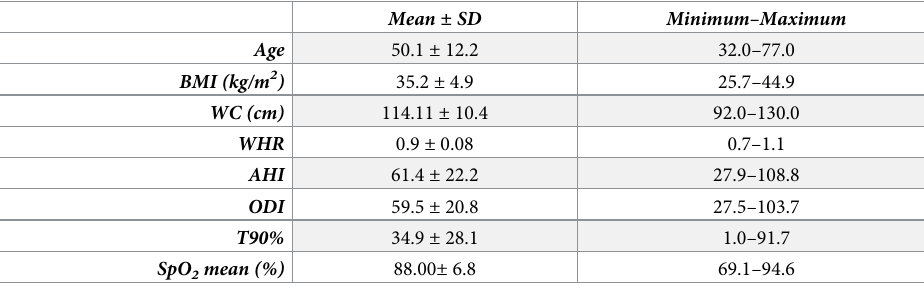
Table 1. Anthropometric characteristics and respiratory parameters during